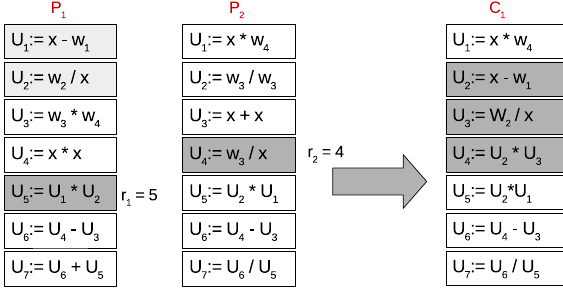
Figure 1. Example of a SLP